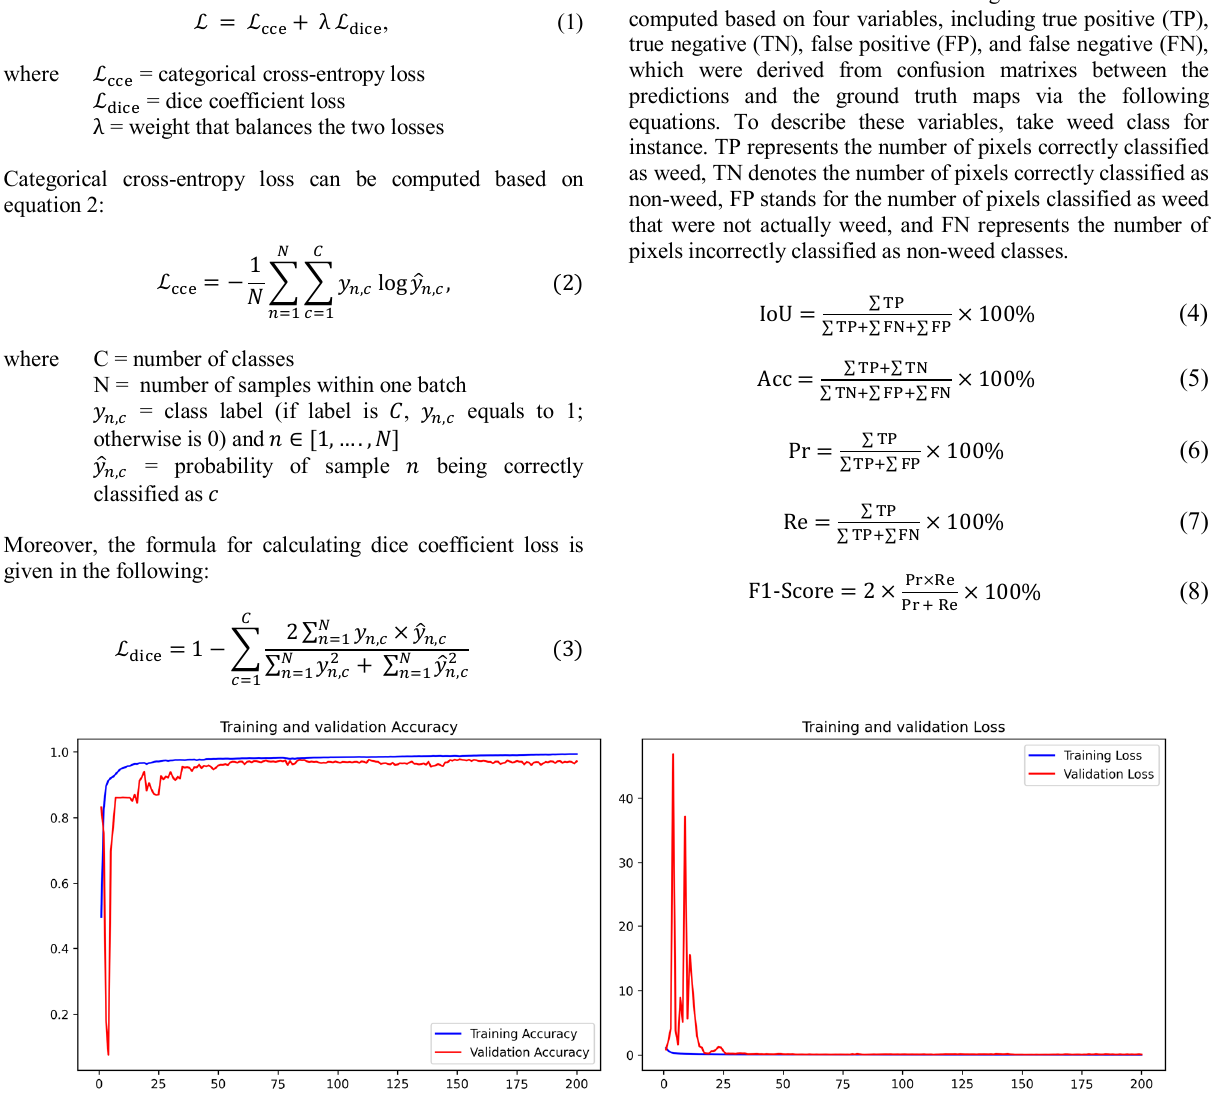
Figure 3 . The accuracy and loss during training U-Net model.